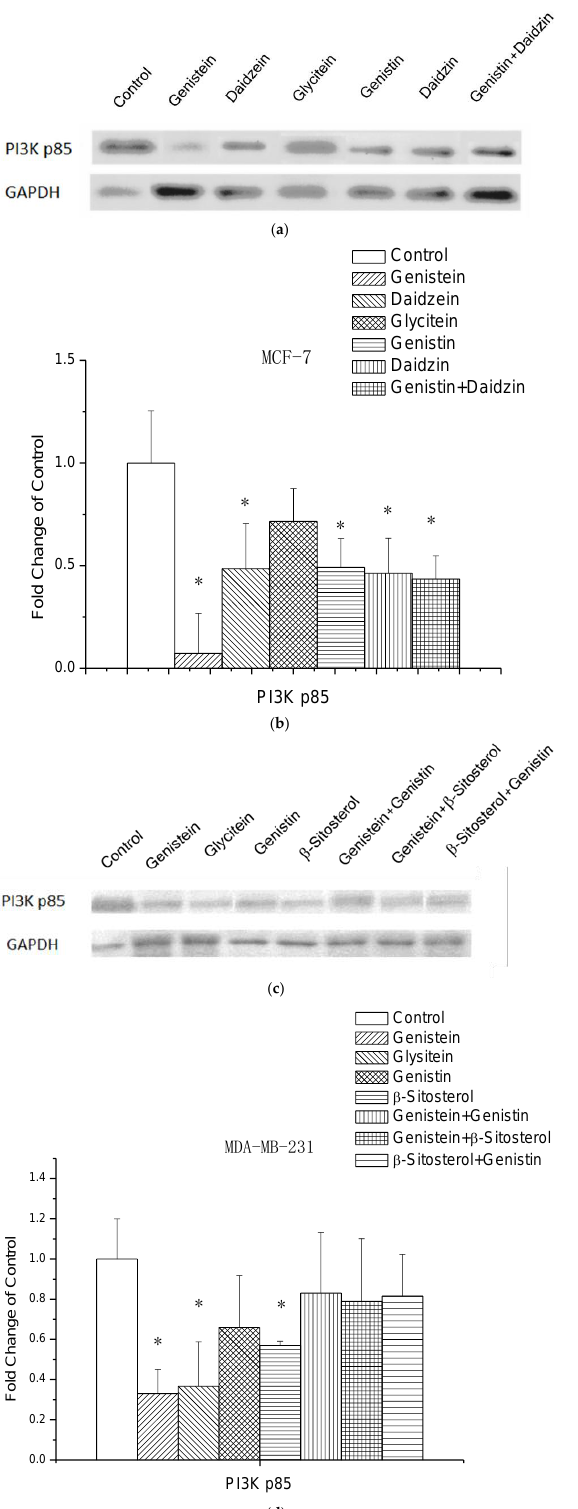
Figure 6. The protein expression level of PI3K p85. Cells were treated with samples, or control for 72 h. Total protein was extracted for the analysis using Western blot. The signal of target protein in MCF-7 cells ( a , b ) and MDA-MB-231 cells ( c , d ) was detected and quantified using SuperSignal ELISA Pico Chemiluminescent Substrate. Data are presented as mean ± SD. * indicates a significant difference compared to the control ( p < 0.05).